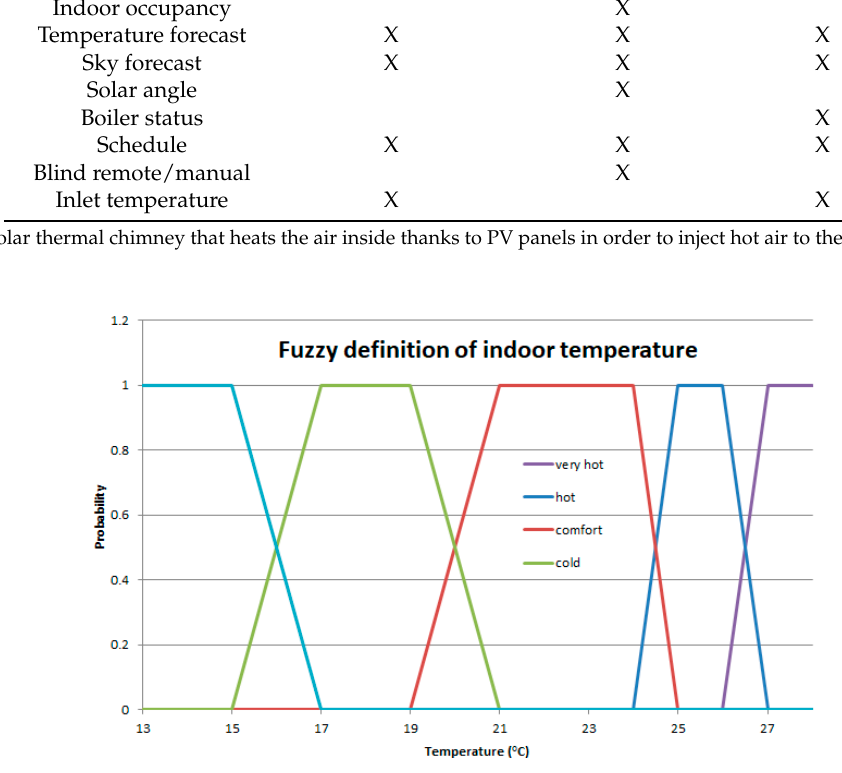
Figure 2. Fuzzification of the indoor temperature variable.